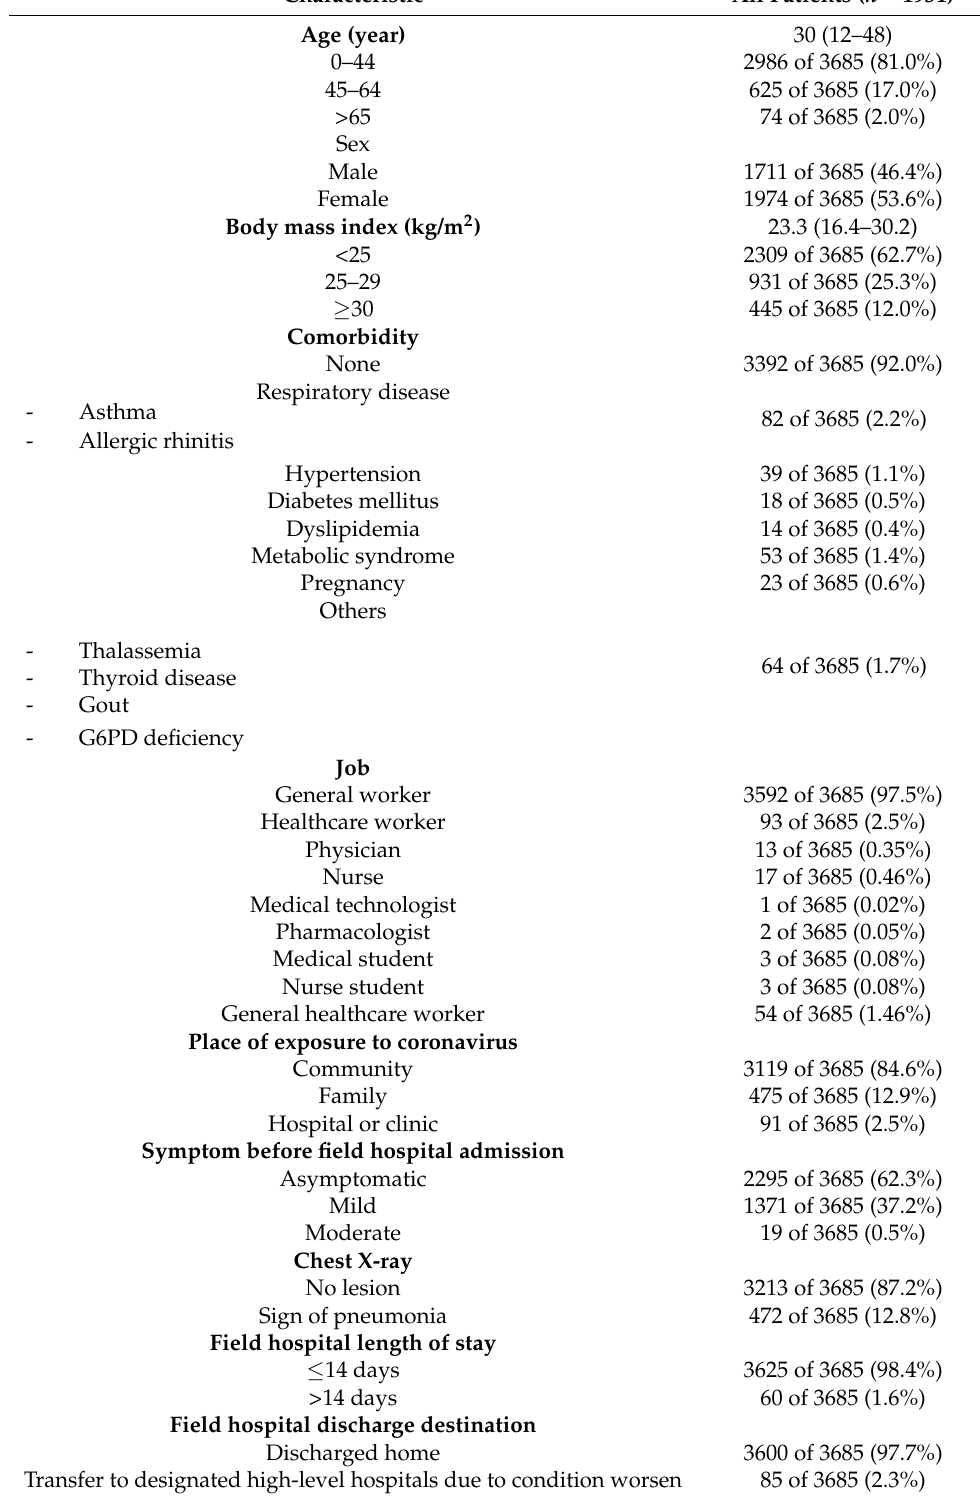
Table 1. Baseline